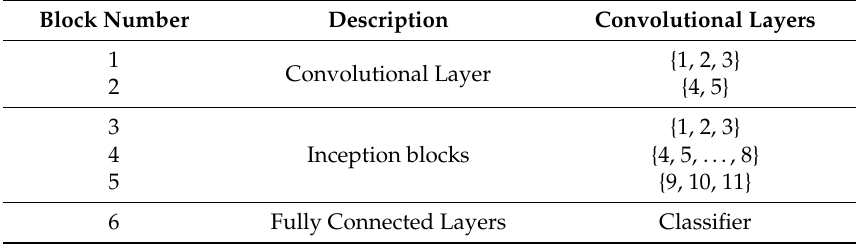
Table 3. Inception-v3 network: block structure and convolutional layers grouping. Block